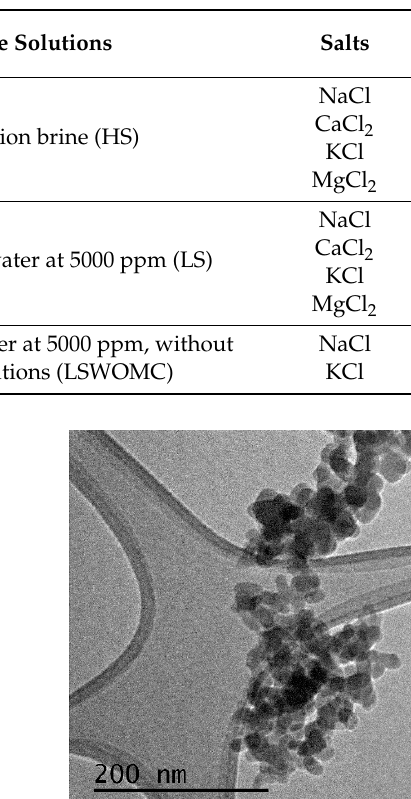
Table 1. Brine solutions used for low salinity experiments, salts and concentrations (in ppm).